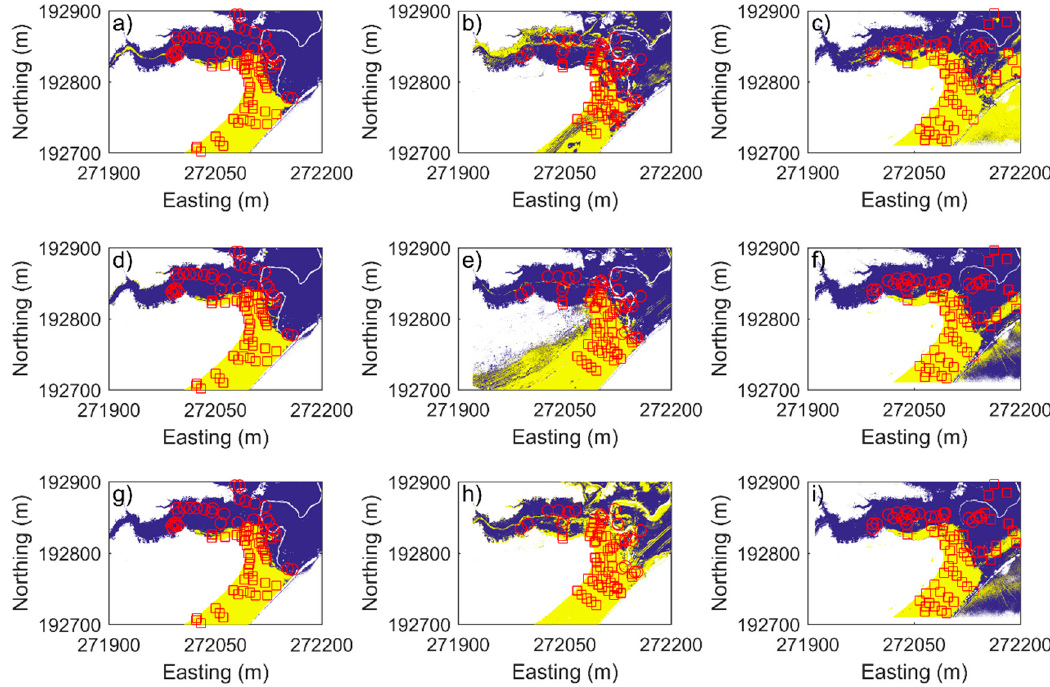
Figure 10. Optimum classification maps for the different flights and classifications. Each row is a classifcation scheme: ( a – c ) k-means; ( d – f ) ANN; ( g – i ) random forests. Column one ( a , d , g ) is the flight on 30/01/2018; column two ( b , e , h ) is the flight on 16/02; and column 3 ( c , f , b ) the flight on 03/05/2018. Sand areas are colored yellow and mud areas colored blue. Visually classified points are marked in red (sand as squares and mud as circles). Table 4. j -index and the upper and lower 95% confidence intervals for all flights and classifications. The statistical similarity is shown by values of the j -index falling within the confidence intervals of other classifications.